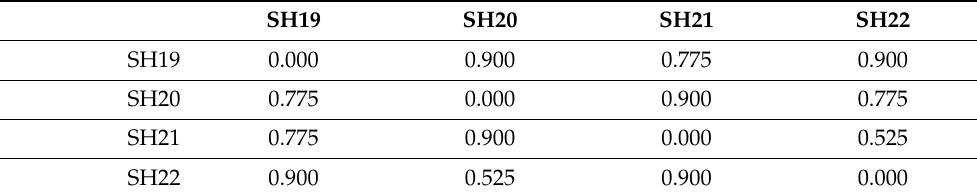
Table 6. Initial intuitionistic fuzzy matrix in standard fuzzy subsets—Expert 1 (human talent sub-criteria).